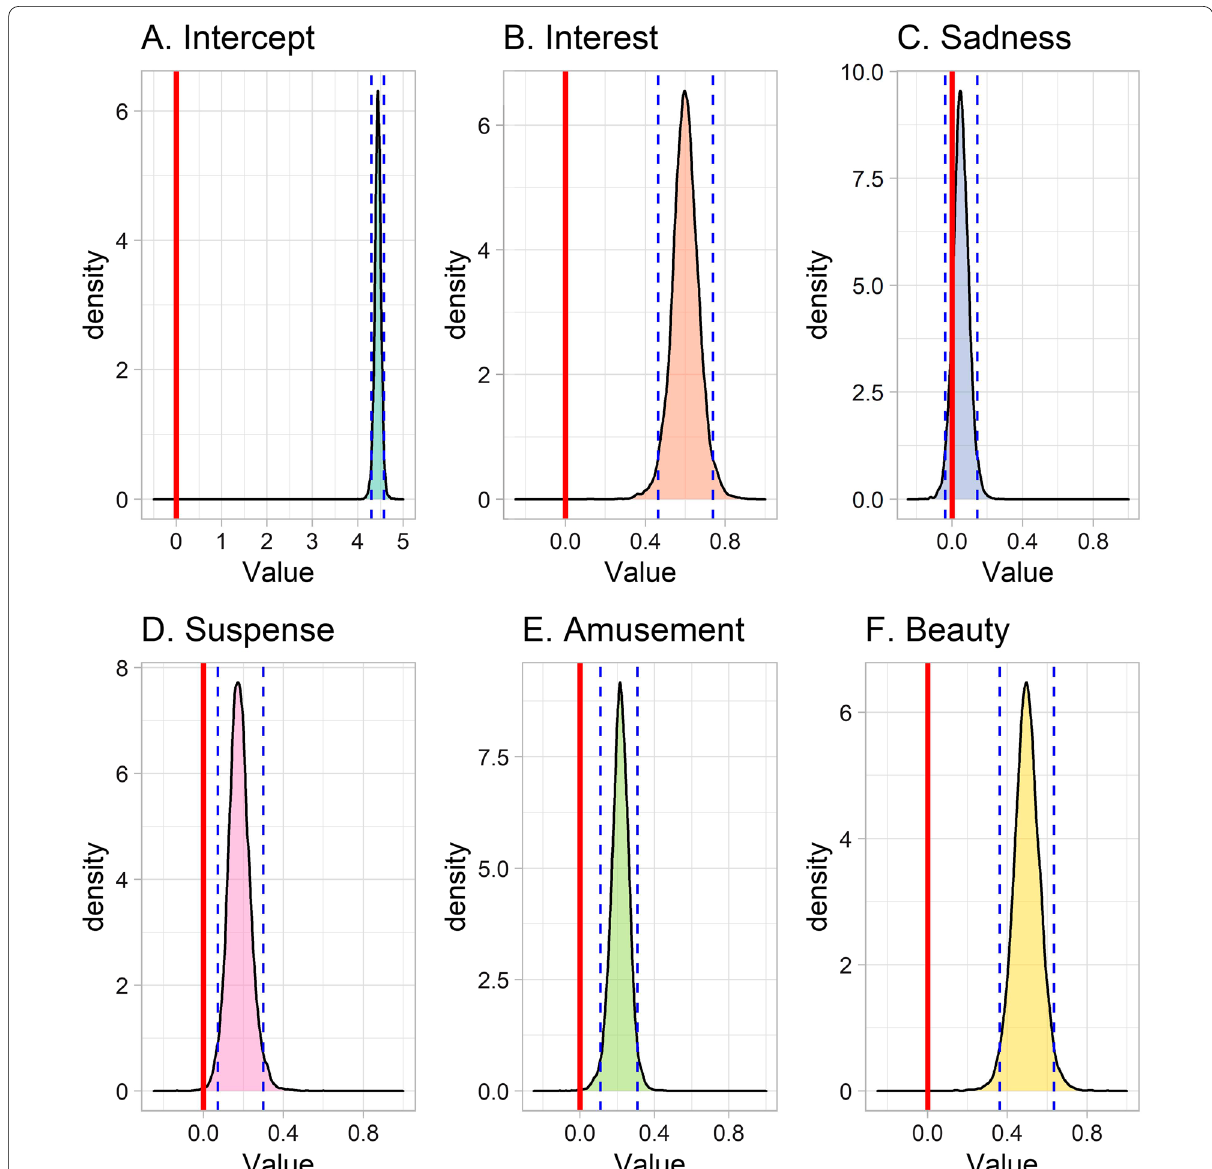
Fig. 2 Posterior distributions of the population-level fixed effects of the relationships between the components and liking. Note The Intercept (A) represents the average liking score. The blue dashed lines indicate the limits of the 95% credible interval. If the credible interval of a parameter does not cross zero, this means that it is likely that the true value for that parameter is different from zero. Code for this figure is adapted from https:// www. rensv andes choot. com/ tutor ials/ brms- start